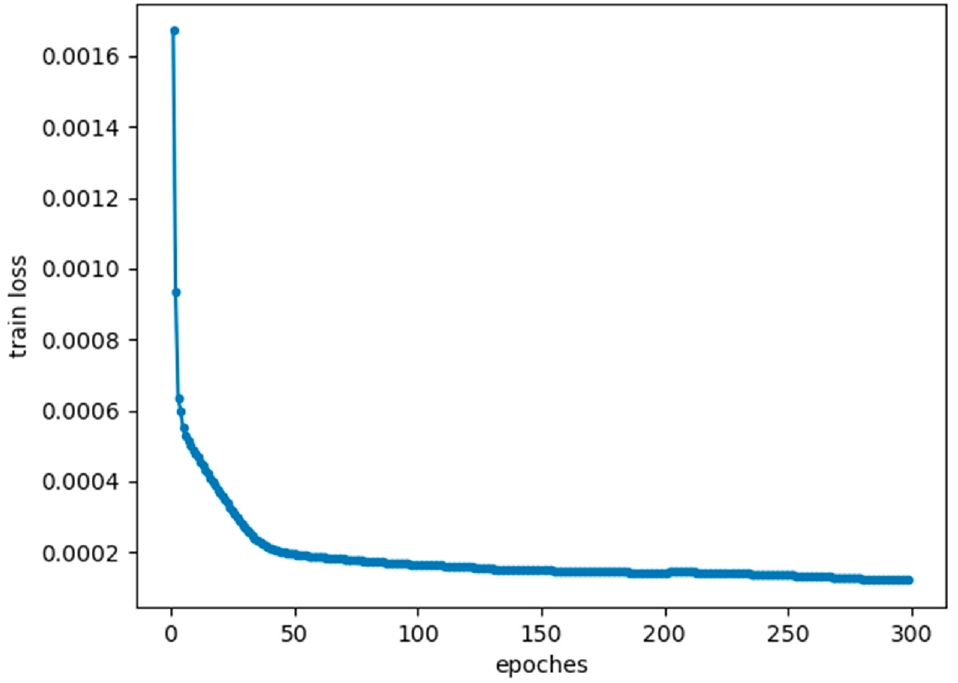
Figure 4. Relationship between iteration times and loss function.